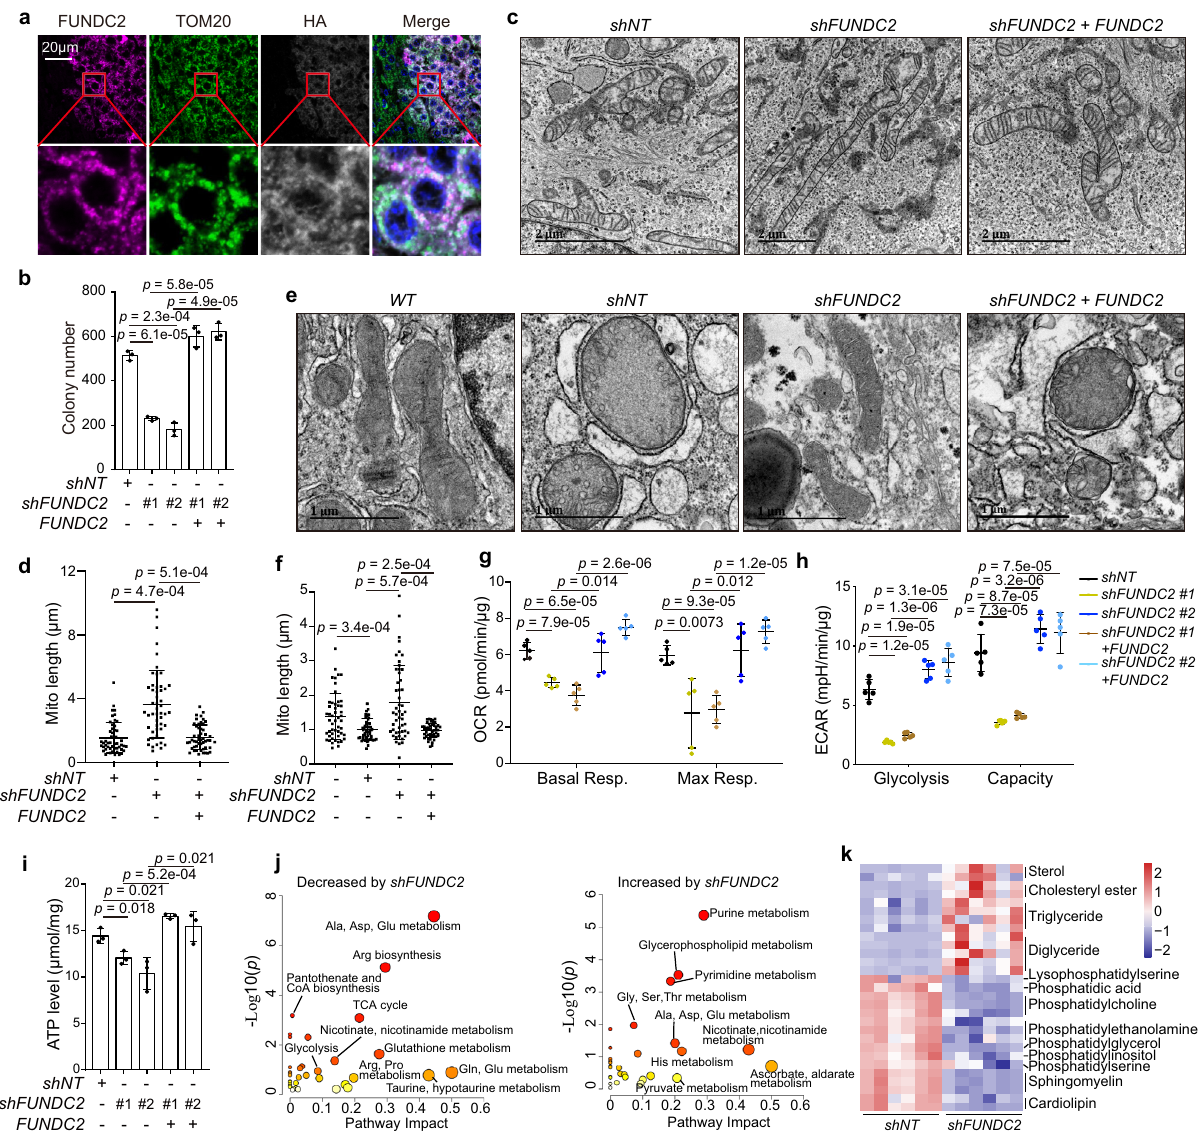
Fig. 3 FUNDC2 promotes mitochondrial fragmentation and reprograms metabolism. a FUNDC2 localized to mitochondria in MYC + RAS tumors. Multiplexed IHC staining of liver sections. Insets were enlarged for details. This experiment was repeated twice. b Knockdown of FUNDC2 in Huh-7 cells reduced colony formation. Colonies were quanti fi ed by Image J, n = 3. c Mitochondrial morphology of Huh-7 cells as revealed by electron microscopy. d Quanti fi cation of mitochondrial length in c , n = 50 mitochondria. e FUNDC2 regulates mitochondrial morphology in MYC + RAS tumors as determined by electron microscopy. f Quanti fi cation of mitochondrial length in e , 50 mitochondria were quanti fi ed. g , h FUNDC2 knockdown reduced mitochondrial respiration and glycolysis. Indicated Huh-7 stable cells were subjected to seahorse analysis. OCR ( g ) and ECAR ( h ) were quanti fi ed, n = 5. i FUNDC2 knockdown reduced cellular ATP level in Huh-7 cells, n = 3. j Metabolic reprogramming in tumors by FUNDC2 knockdown as revealed by targeted metabolomics. Pathway enrichment analysis was performed on differential metabolites. k Heatmap cluster analysis of lipid metabolites with differential abundance by FUNDC2 knockdown in tumors, n = 6. n was biological replicates for all experiments. Data are presented as mean ± SD. p values